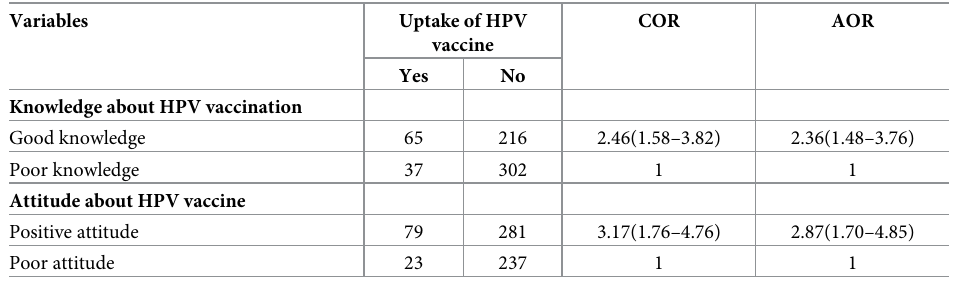
Table 6. Factors associated with uptake of HPV vaccine among female preparatory school students, Bahir Dar, Ethiopia,